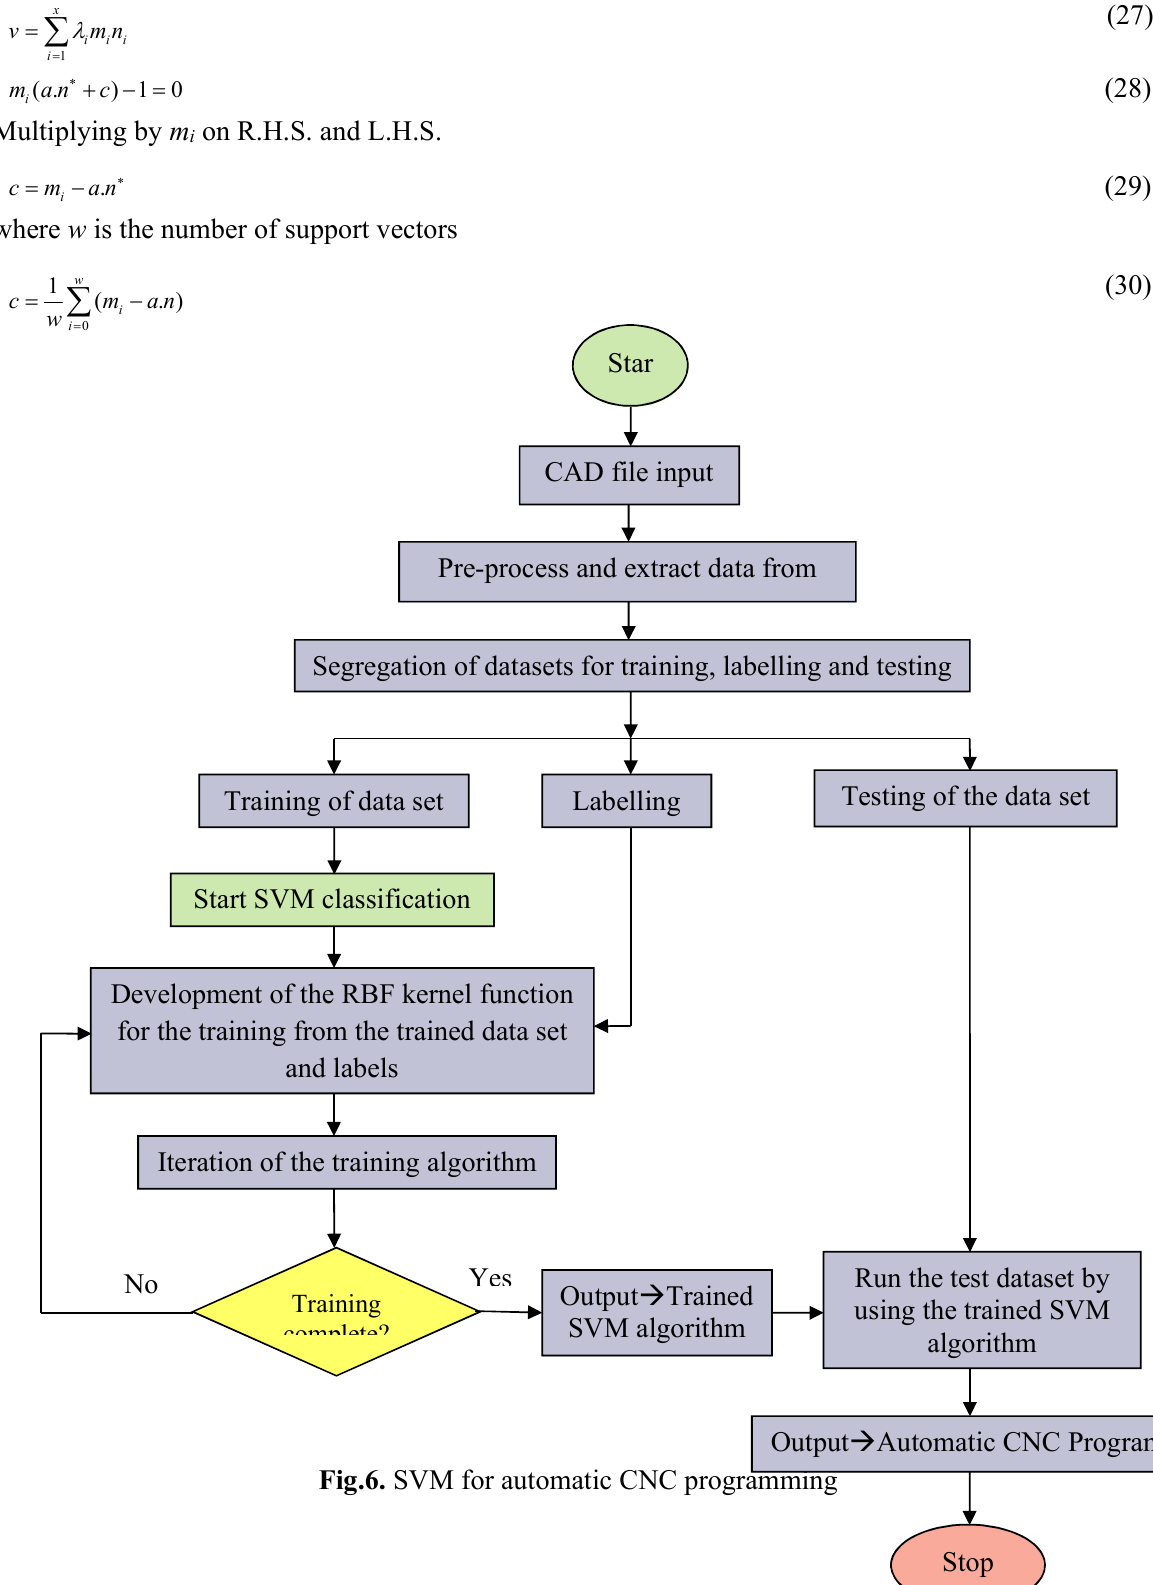
Fig.6. SVM for automatic CNC programming